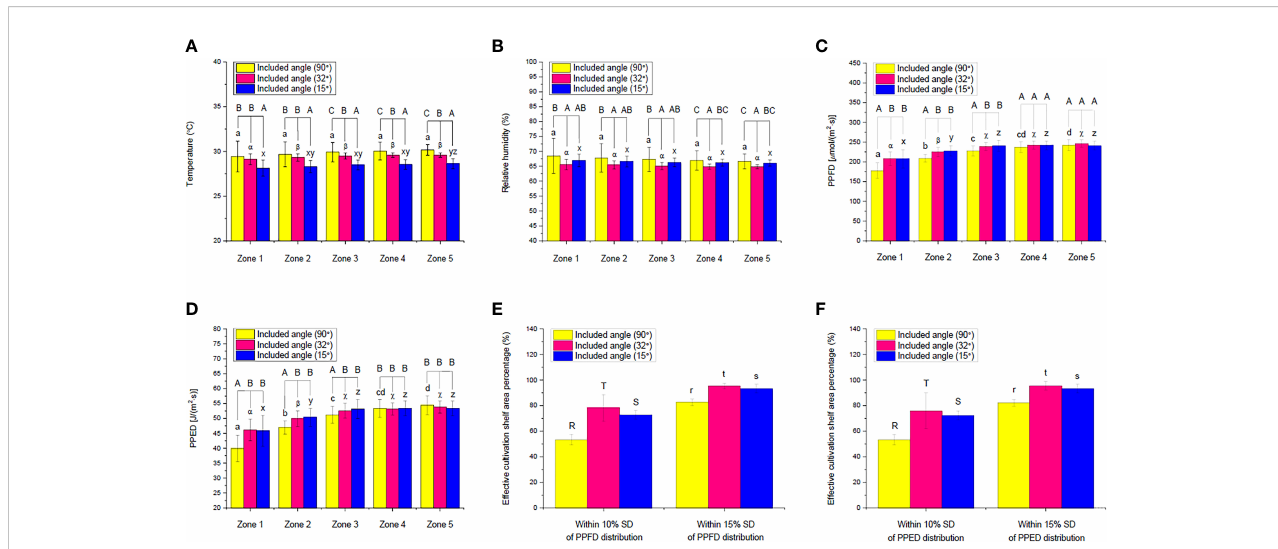
FIGURE 7 Comparisons of the measured (A) temperature, (B) relative humidity, (C) photosynthetic photon fl ux density (PPFD) and (D) photosynthetic photon energy density (PPED) in different shelf zones of an indoor farm rack under different included angles of an adjustable lampshade-type re fl ector as well as effective cultivation shelf area percentages within different SD of PPFD distribution under (E) PPFD-based and (F) PPED-based conditions. Different uppercase letters (A, B, and C) indicate signi fi cant differences among different included angles in the respective zones; different lowercase letters (a, b, c, d, x, y, and z) and Greek alphabets ( a , b , and c ) indicate signi fi cant differences among all the zones under the respective included angles; different uppercase letters (R, S, and T) and lowercase letters (r, s, and t) indicate signi fi cant differences among the different included angles within 10% and 15% SD of the PPFD/PPED distribution along the whole shelf, respectively ( N zone1 = 56, N zone2 = 48, N zone3 = 40, N zone4 = 32, N zone5 = 24, N total = 200, one- way ANOVA; Tukey multiple-comparison; p <